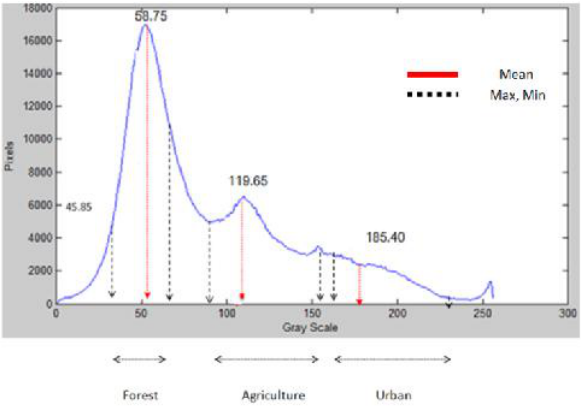
Figure 3. Grayscale histogram image and thresholding set